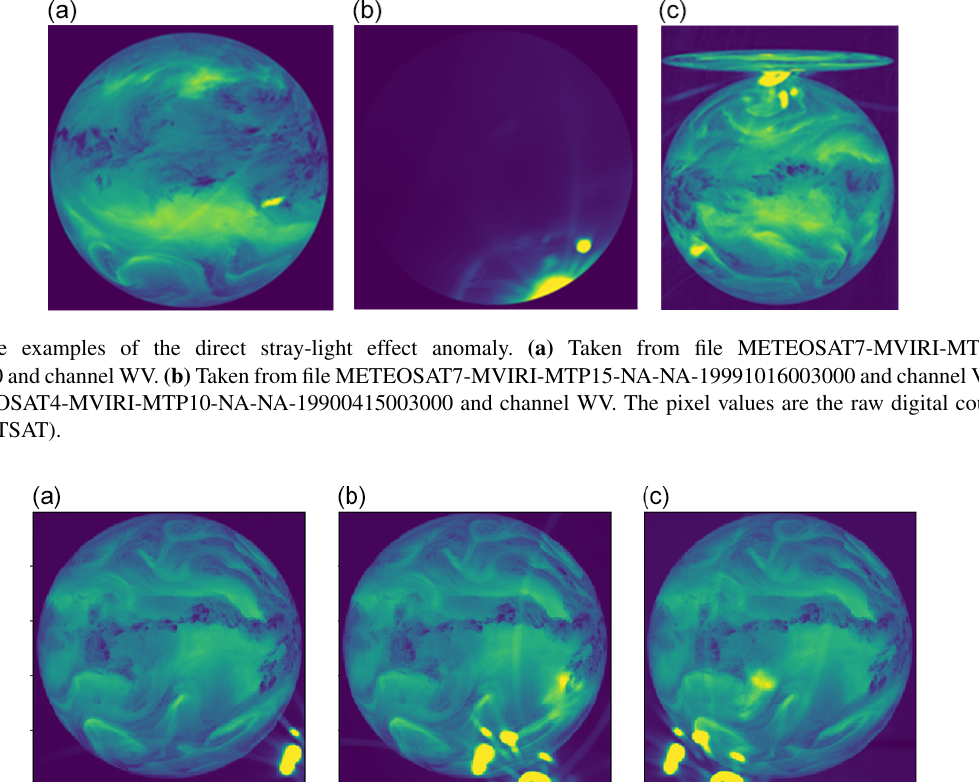
Figure 8. Three sequential images affected by the direct stray-light anomaly. (a) Taken from file METEOSAT5-MVIRI-MTP10-NA- NA19961015300000 and channel WV. (b) Taken from file METEOSAT5-MVIRI-MTP10-NA-NA19961016000000 and channel WV. (c) Taken from file METEOSAT5-MVIRI-MTP10-NA-NA19961016300000 and channel WV. The pixel values are the raw digital counts (see also Fig. 2; ©EUMETSAT).